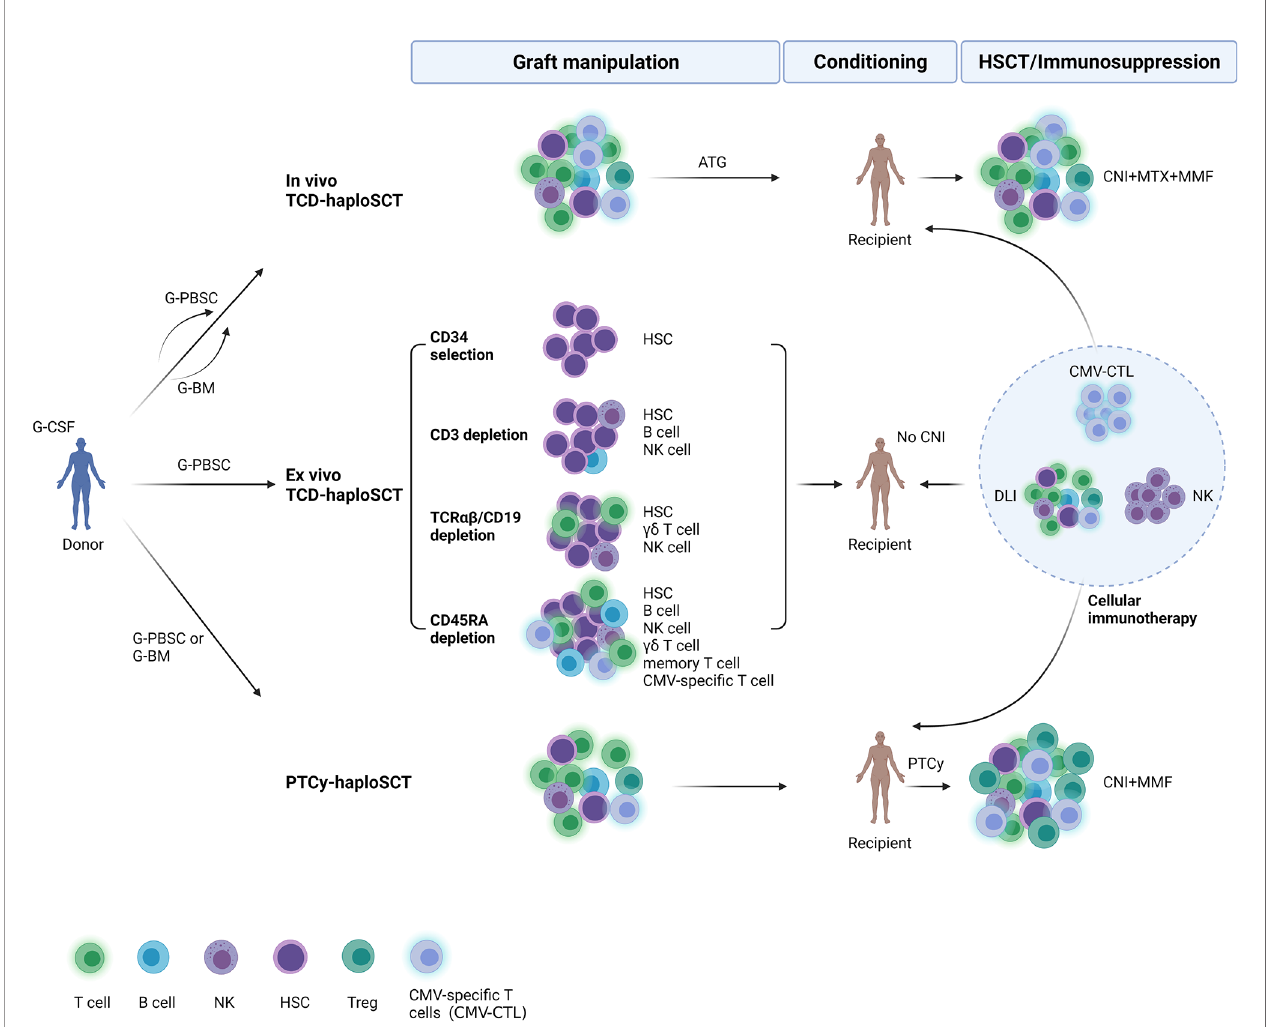
FIGURE 1 | Overview of immune reconstitution to cytomegalovirus and cellular immunotherapy after three major approaches of haploidentical stem cell transplantation (haploSCT). In vivo TCD-haploSCT, in vivo T-cell depletion (TCD) using antithymocyte globulin for haploSCT; Ex vivo TCD-haploSCT, ex vivo TCD using CD34+positive selection for haploSCT; PTCy-haploSCT, T-cell replete haploSCT using posttransplant cyclophosphamide. G-CSF, granulocyte-colony stimulating factor; G-PBSC, G-CSF primed peripheral blood stem cells; G-BM, G-CSF primed bone marrow; HSC, hematopoietic stem cell; CMV, cytomegalovirus; CNI, calcineurin inhibitors; MTX, methotrexate; MMF, mycophenolate mofetil; DLI, donor lymphocyte infusion; NK cell, natural killer cell; Treg, regulatory T cell; HSCT, hematopoietic stem cell transplantation. Created with BioRender